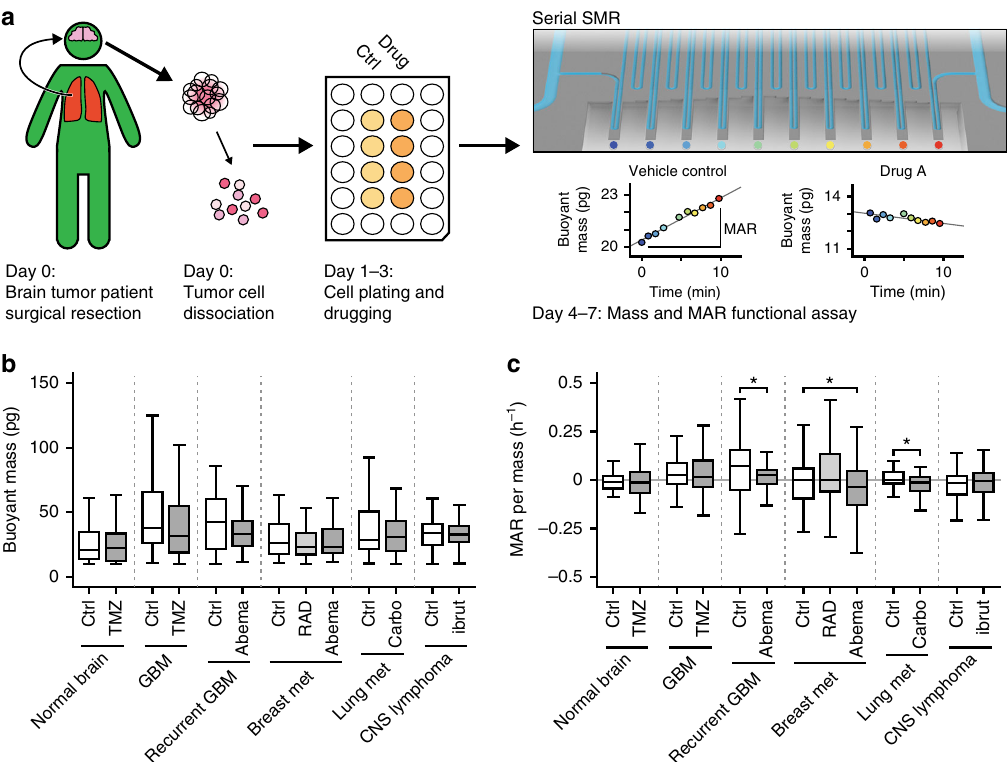
Fig. 3 Ex vivo drug sensitivity testing of patient resections. a Sample processing pipeline for sSMR measurement with active loading. Tumor cells were isolated from patient resection specimens using established protocols 12 (see Methods, Supplementary Note 7) for dissociation into single-cell suspension and allowed to recover for at least 24 h before the addition of drug or vehicle control. On subsequent days, the buoyant mass and MAR were measured for both the control and drug-treated fractions. b Tukey's box plot showing the buoyant mass measurements for primary biopsies of different brain lesions. From left to right, number of cells measured: n = 86, 90, 63, 64, 66, 83, 74, 60, 47, 53, 54, 164, and 188. c Tukey's box plot showing mass-normalized MAR values from the same primary tissue samples shown in b . Statistically signi fi cant reductions in MAR per mass (* p < 0.05 in highlighted segments) were observed for the recurrent glioblastoma treated with 1 μ M abemaciclib for 72 h ( p = 0.032), breast metastasis treated with 100 nM abemaciclib ( p = 0.029), and lung metastasis treated with 100 μ M carboplatin ( p = 0.025). All other drug-control comparisons did not show a statistically signi fi cant response. Additional information about the handling of each primary sample can be found in Supplementary Note 7 and exact p values can be found in Supplementary Notes 9 – 14. For both b , c , the center line shows median value, hinges represent the fi rst and third quartiles, and whiskers extend to the furthest value <1.5× IQR from